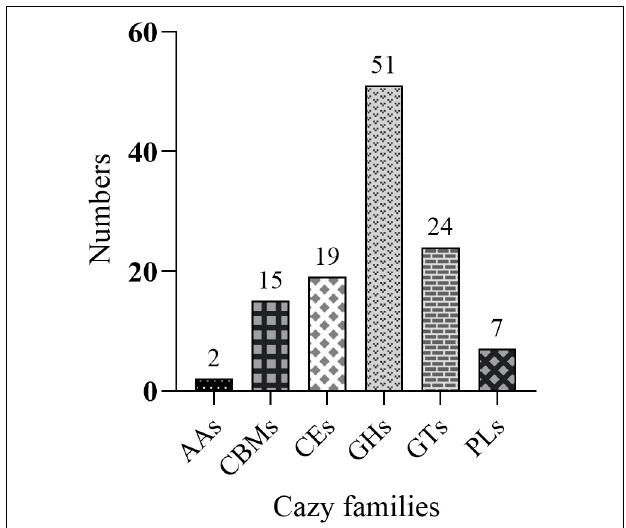
FIGURE 7 | Distribution of CAZy families in the genome of B. subtilis YB-04.